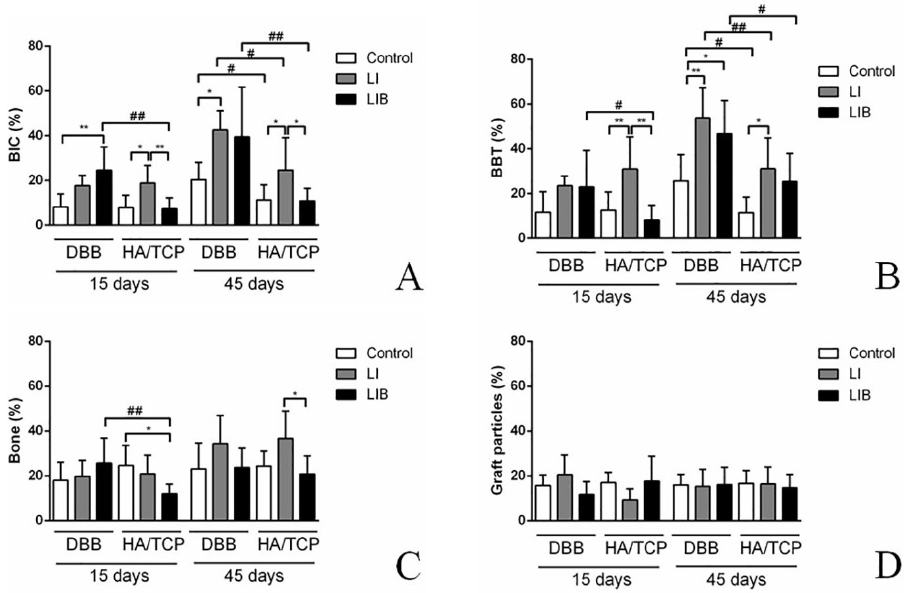
Figure 4- Representative graphs of the mean and standard deviation of the histometric analysis data. A) %BIC; B) %BBT; C) % bone; D) % biomaterial. * p<0.05; ** p<0.01 - Significant differences between the different protocols of LLLT (Control, LI, and LIB); # p <0.05; ## p<0.01 - Significant differences between the different bone substitutes – Two-way ANOVA complemented by Tukey’s